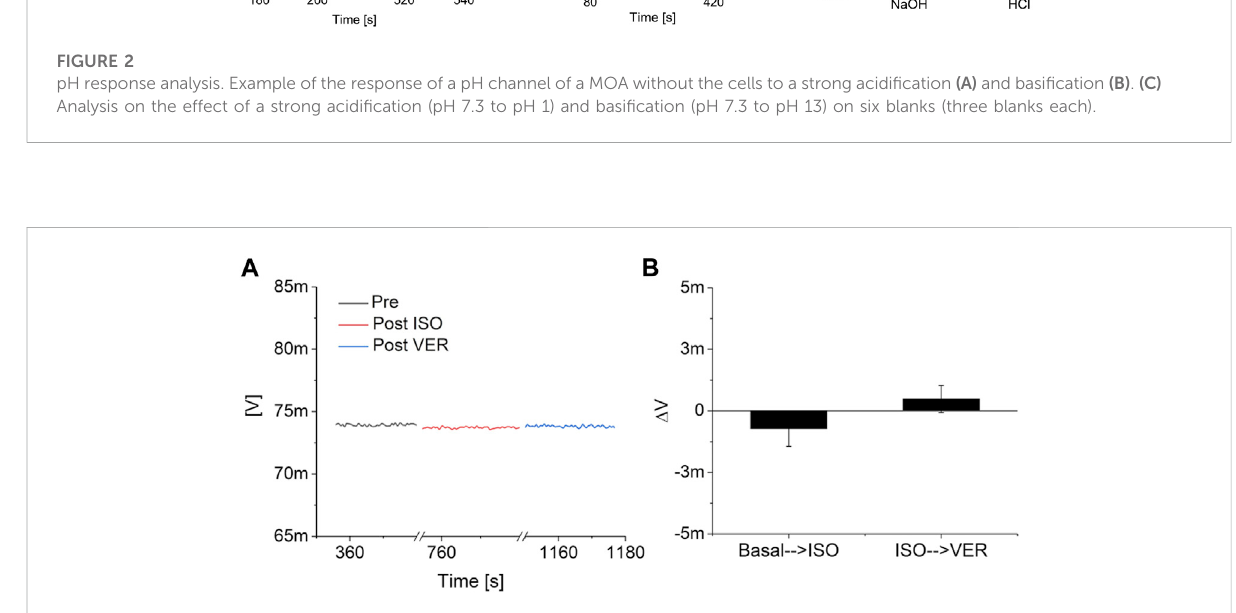
FIGURE 3 Drugs response analysis. (A) Example of the response of a pH channel of a MOA without the cells to the consecutive addition of 10 nM of Isoprenaline (ISO) and 40 μ M Verapamil (VER). (B) Analysis on three blanks of the effect of the two drugs on the output of the